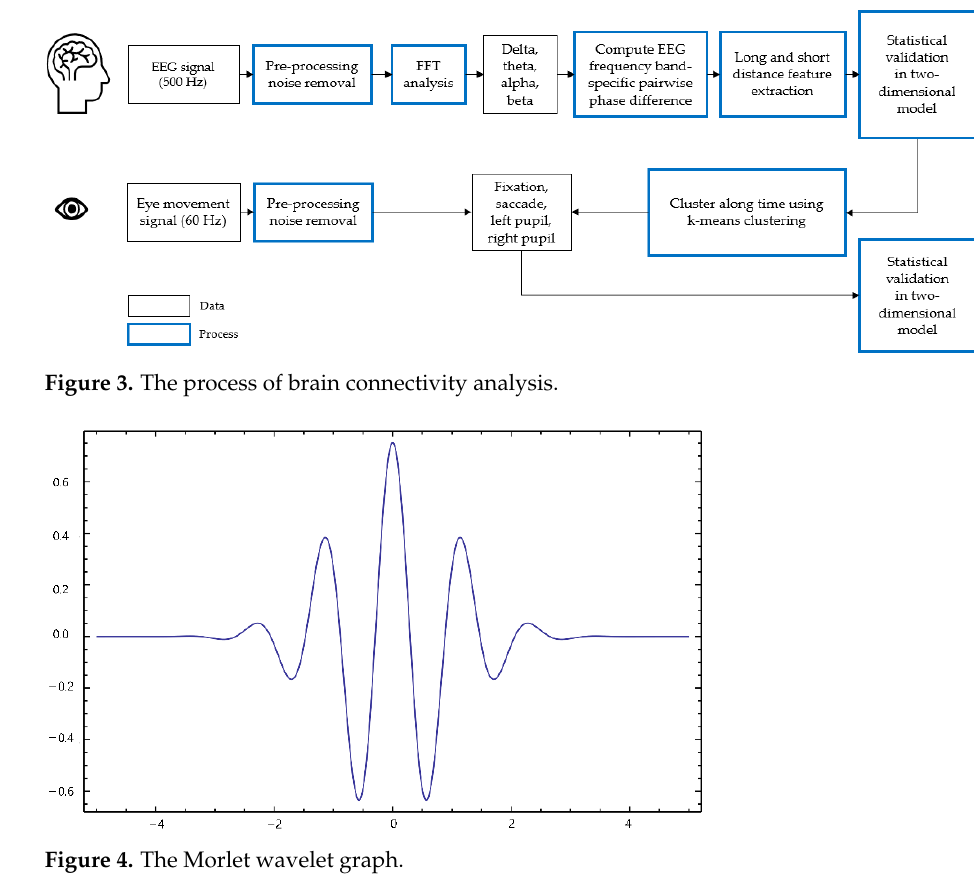
Figure 4. The Morlet wavelet graph.